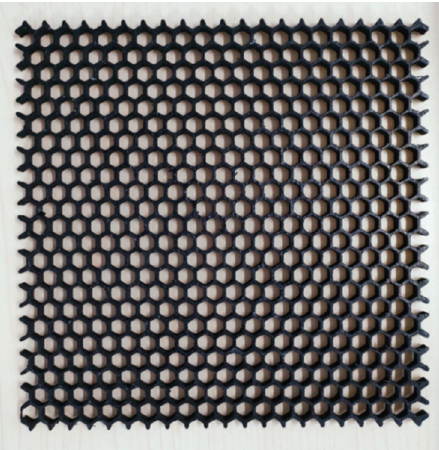
Figure 12. The printed honeycomb structural absorber.